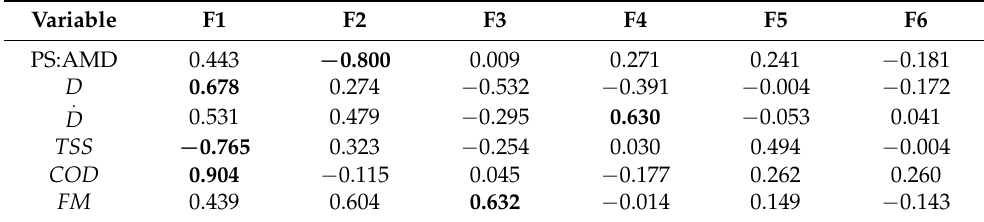
Table 7. Factor loadings based on PCA results.